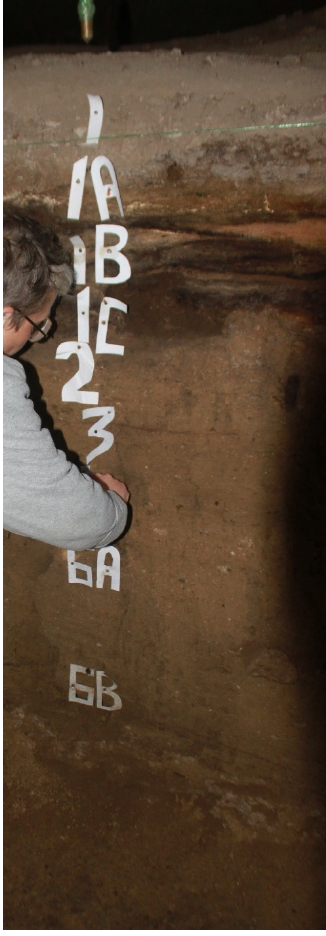
Figure 5. Sampling sediment, Saradj-Chuko Grotto, Russia. To find the sedimentary dose rates for ESR dating, 40 sediment samples were analyzed by NAA from 16 geoarchaeological